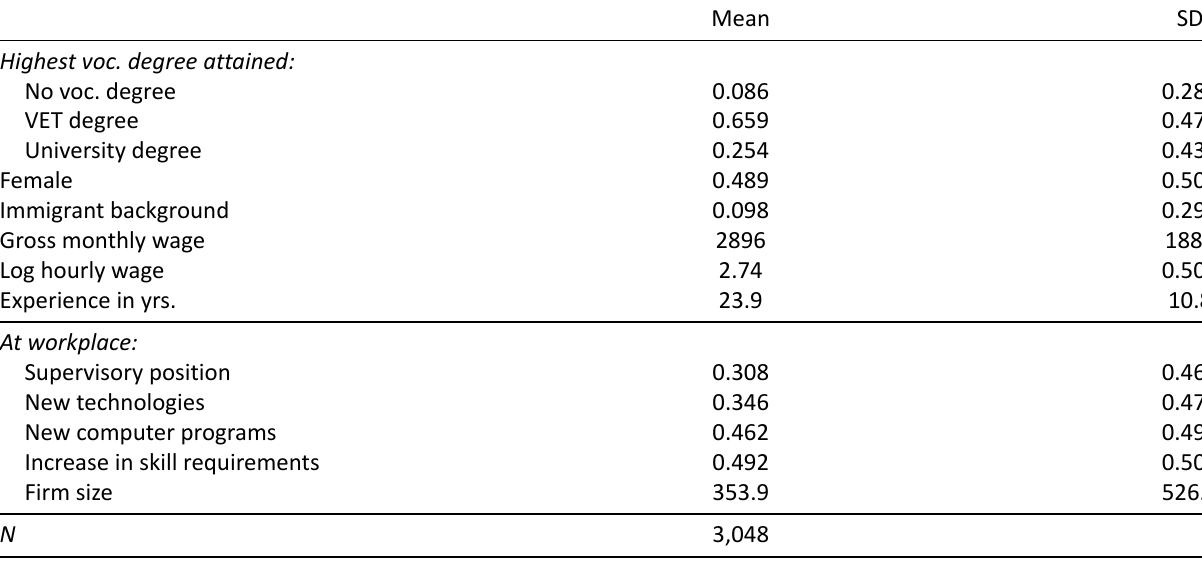
Table 1. Sample summary statistics. Source: BIBB/BAuA Employment Survey 2012 and Supplemental Task Survey to the Employment Survey 2012, weigted by sampling